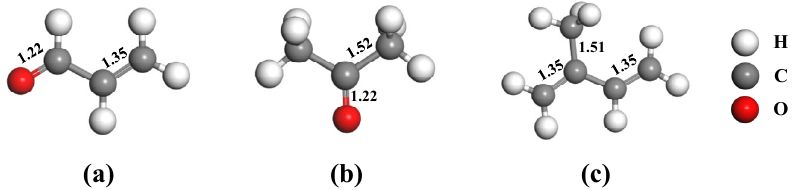
Figure 1. Morphologies of ( a ) C 3 H 4 O, ( b ) C 3 H 6 O and ( c ) C 5 H 8 . The black values are bond length, with unit in Å.